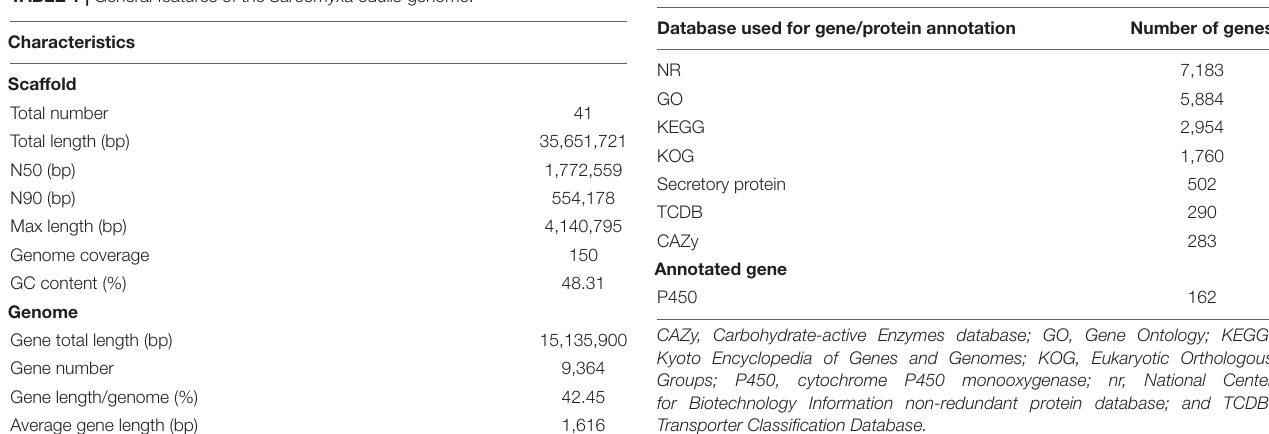
TABLE 2 | Summary of Sarcomyxa edulis gene